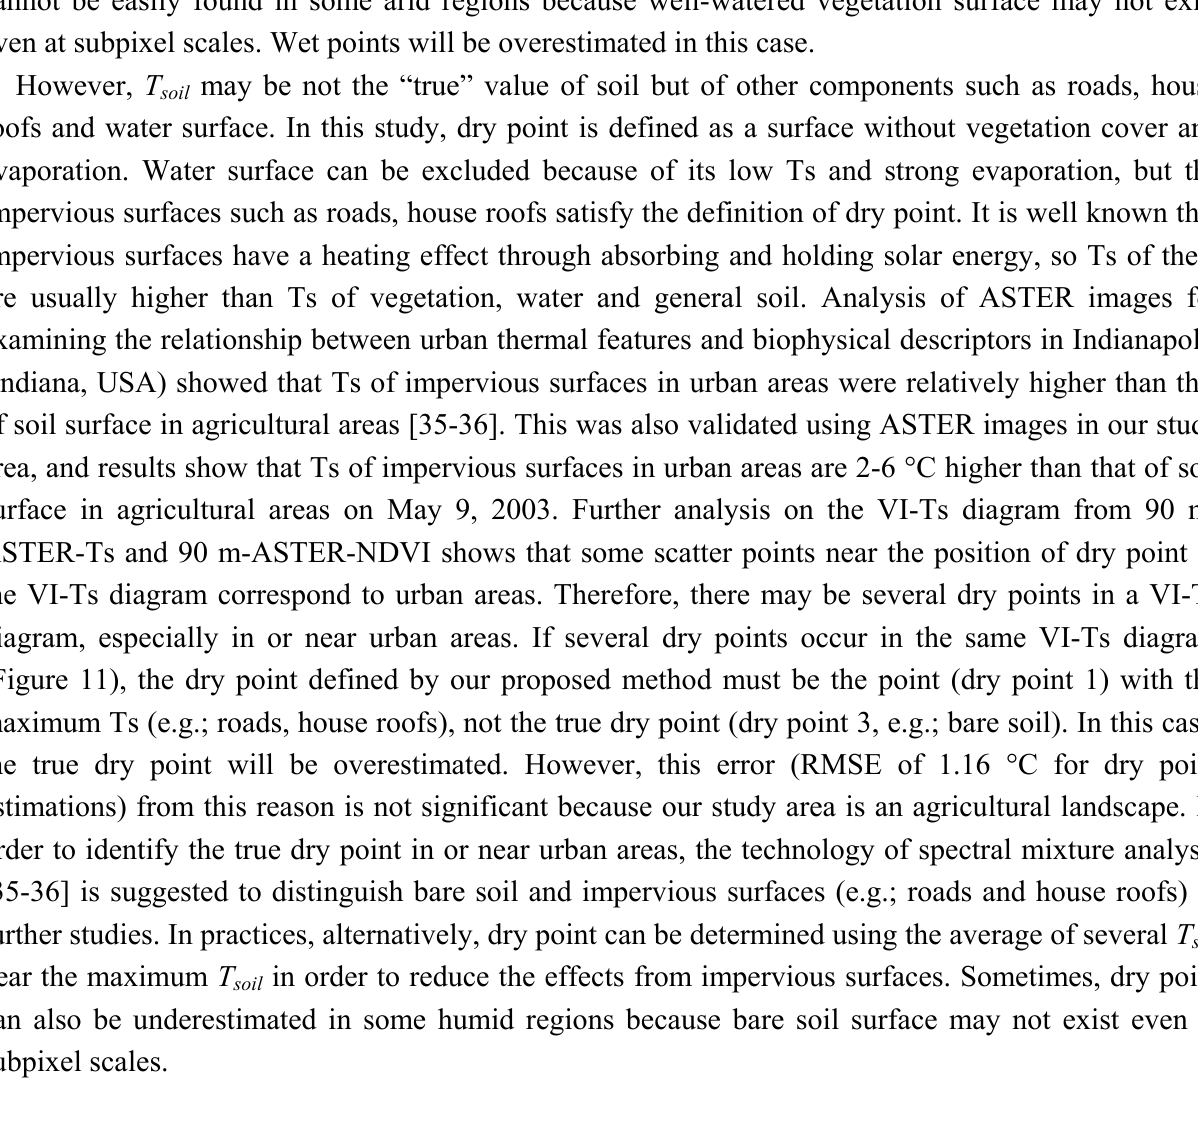
Figure 11. Description of several dry points in the same VI-Ts